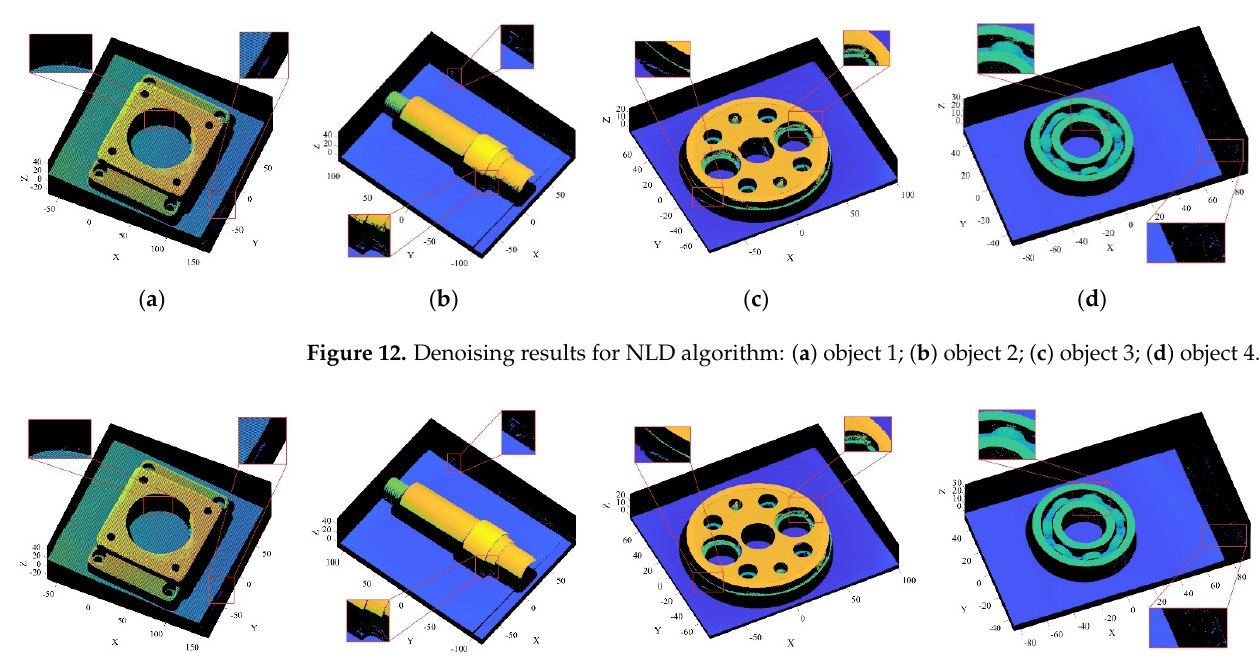
Figure 11. Denoising results for APSS algorithm: ( a ) object 1; ( b ) object 2; ( c ) object 3; ( d ) object 4.